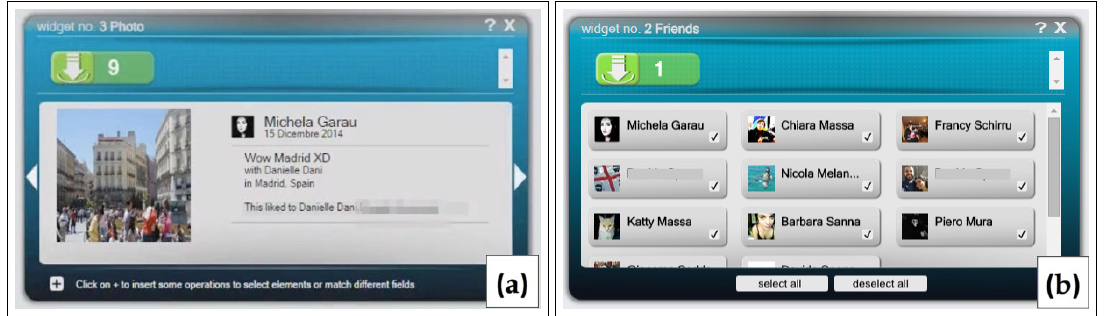
Figure 3. Two examples of content widgets: photo ( a ) and friend list ( b ).